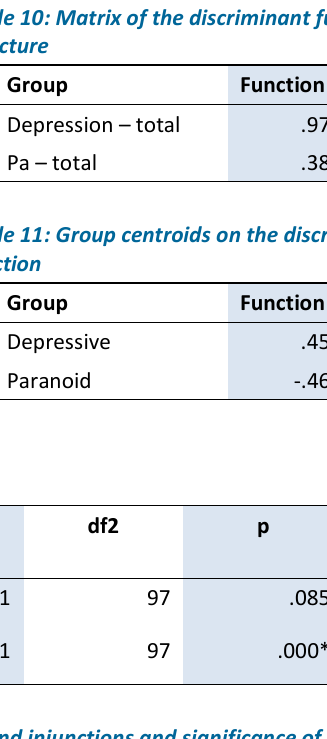
Table 13: Canonical correlation between the LD and Pa scores and injunctions and significance of canonical